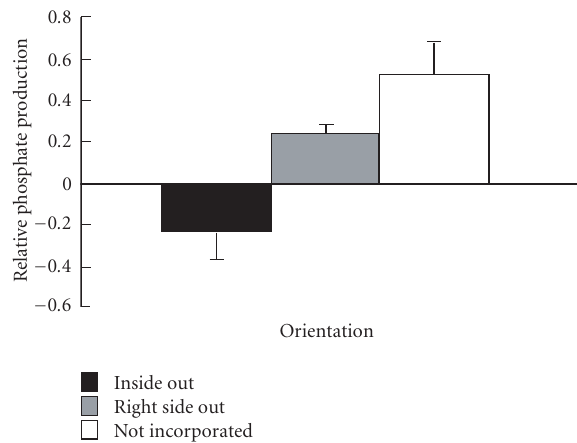
Figure 5: Orientation of Na + K + -ATPase in proteoliposomes measured by the sidedness assay ( n = 3). Proteoliposomes were created by nitrogen filtration, incubated ± ouabain ± detergent and then function (PO 4 production from ATP) was measured and used to calculate sidedness [33] to determine the relative amount of Na + K + -ATPase that was facing inside out, right side out, or was not incorporated. All three orientations of enzyme were statistically di ff erent from each other ( P < . 05).